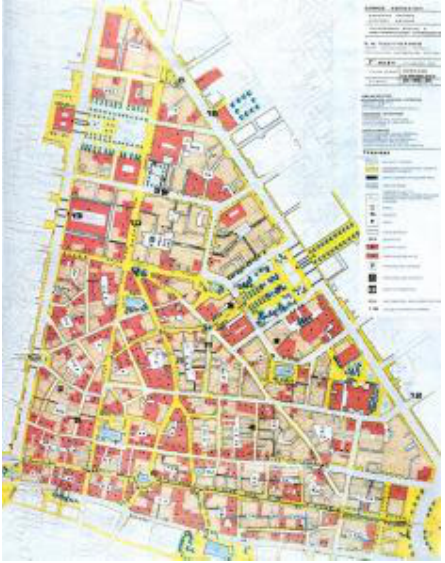
Fig. 3. Aravantinos et al, Master Plan for the Historical Centre of Athens, Urban Research Laboratory, School of Architecture, NTUA (1996):